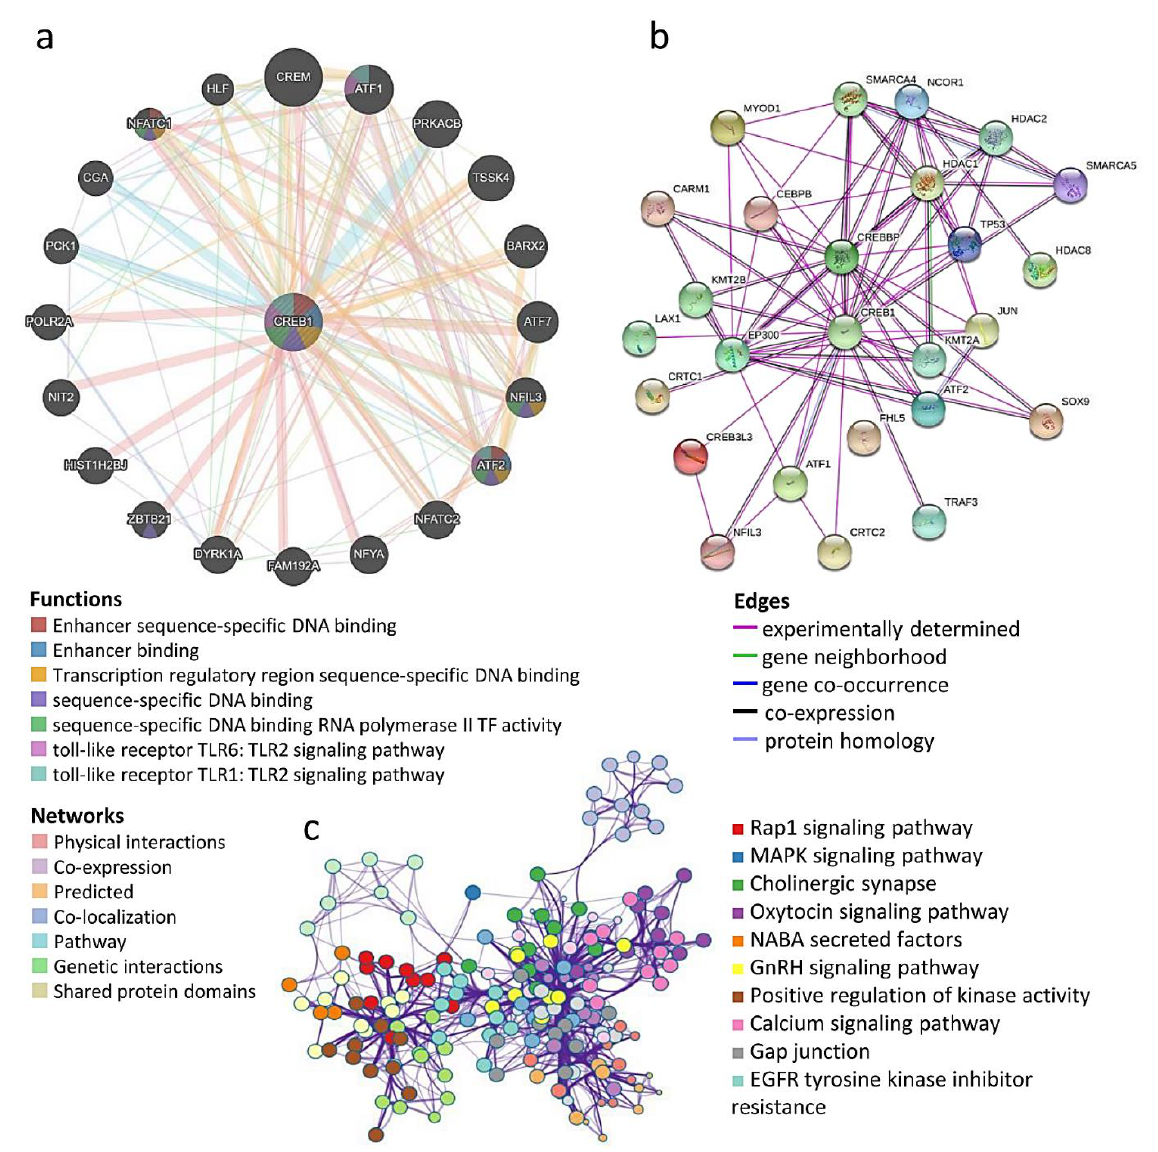
Figure 5. Network data improves the target prediction ( a ) and ( b ) predicted PPI essential for the functions of CREB1 generated from Pathway Commons and String website. ( c ) Metascape functional enrichment analysis and OV clinical relevance of CREB1-regulated DEGs. One term per cluster, colored by p values. Log10 (p) is the p value in log base 10.